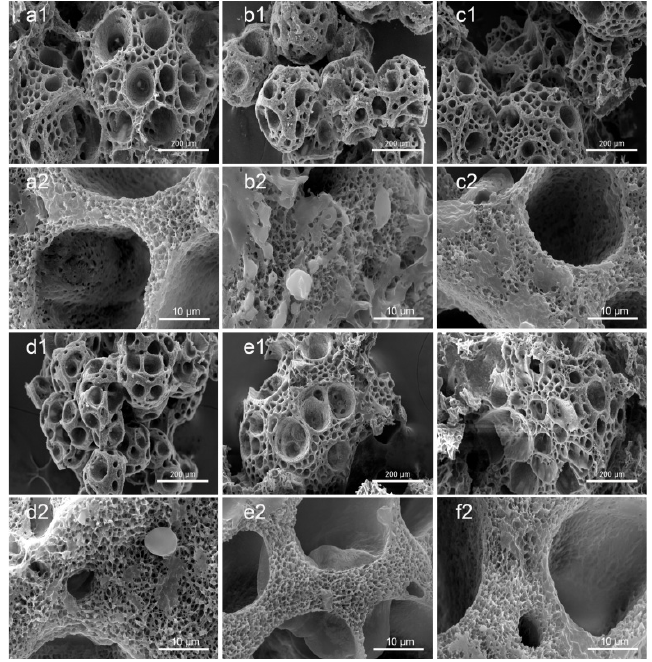
Figure 11. Morphology of dual drug-loaded biomimetic composite scaffold after sustained release for 9 days: ( a1 , a2 ) S0A5, ( b1 , b2 ) S1A5, ( c1 , c2 ) S3A5, ( d1 , d2 ) S5A5, ( e1 , e2 ) S3A10 and ( f1 , f2 ) S3A15.